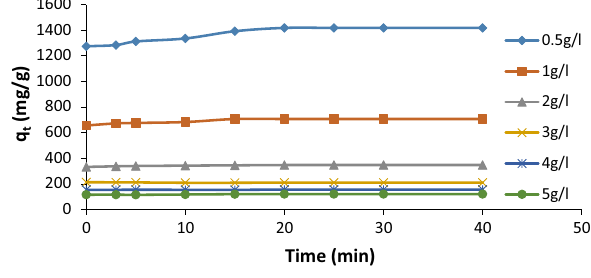
Fig. 9 The plot of adsorptive capacity, q